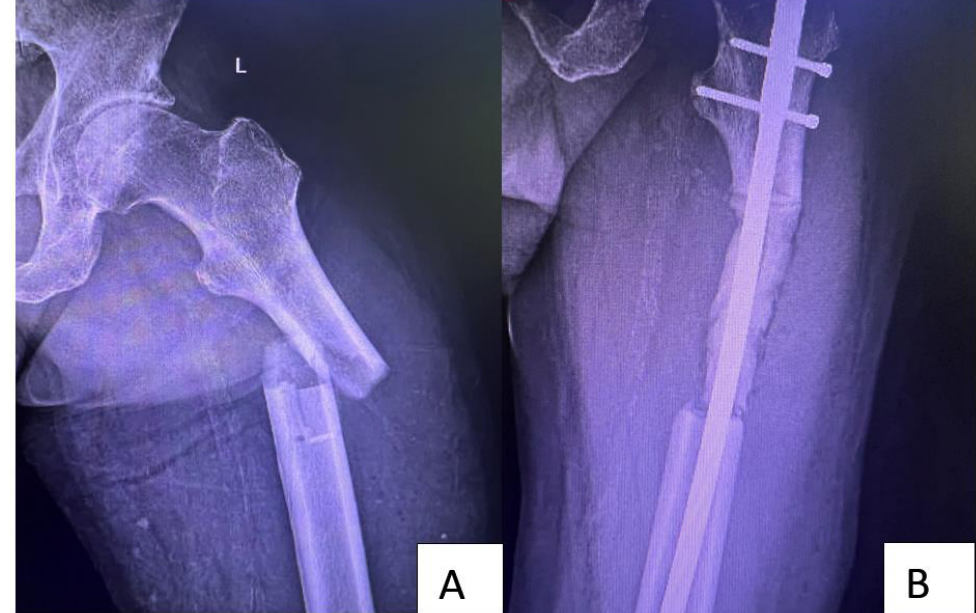
Figure 3. Preoperative X-ray ( A ) of a 56-year-old male with a history of recently diagnosed non-small-cell lung cancer (NSCLC) and a pathological bone fracture. After multidisciplinary evaluation, no other secondary tumor was found. Due to the fracture, the approach chosen was metastatic resection followed by intramedullary nail and acrylic bone cement ( B ). The conduct in the case of this patient was to carry out periodic imaging evaluations and to replace the nail if the local and general situation allowed a push-through modular component. Imaging evaluations performed at 12 months detected multiple metastases, so replacement with a modular component was abandoned.